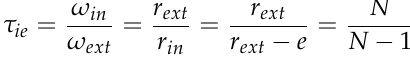
Figure 2. Reference systems for gerotor design.